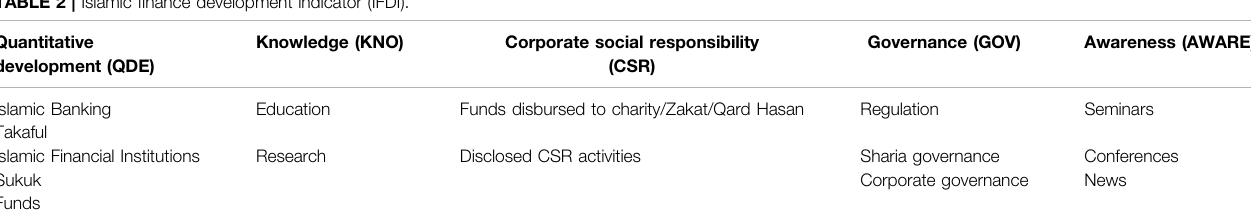
TABLE 2 | Islamic fi nance development indicator (IFDI).